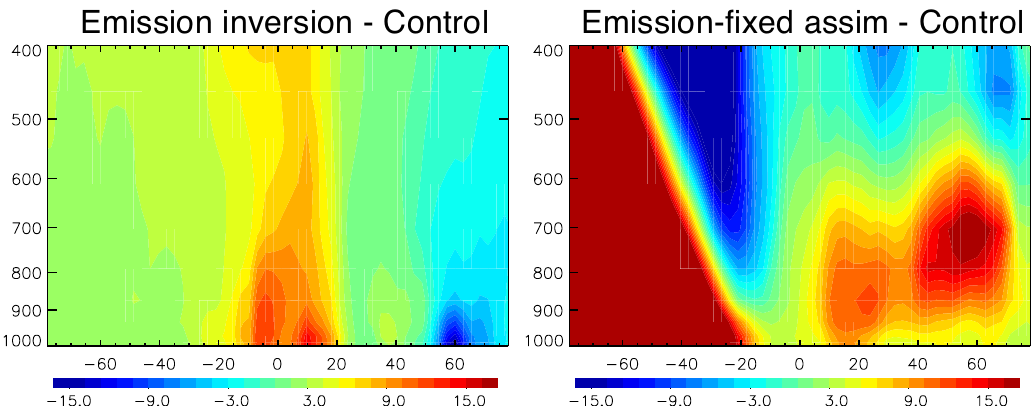
Fig. 15. The latitude-pressure distribution of the relative difference of zonal mean O 3 mixing ratio (in %) between the emission inversion run and the control run (left) and the emission-fixed assimilation and the control run (right) averaged over 16–30 July 2007. The red (blue) colour indicates relatively high (low) values in the inversion/assimilation run.